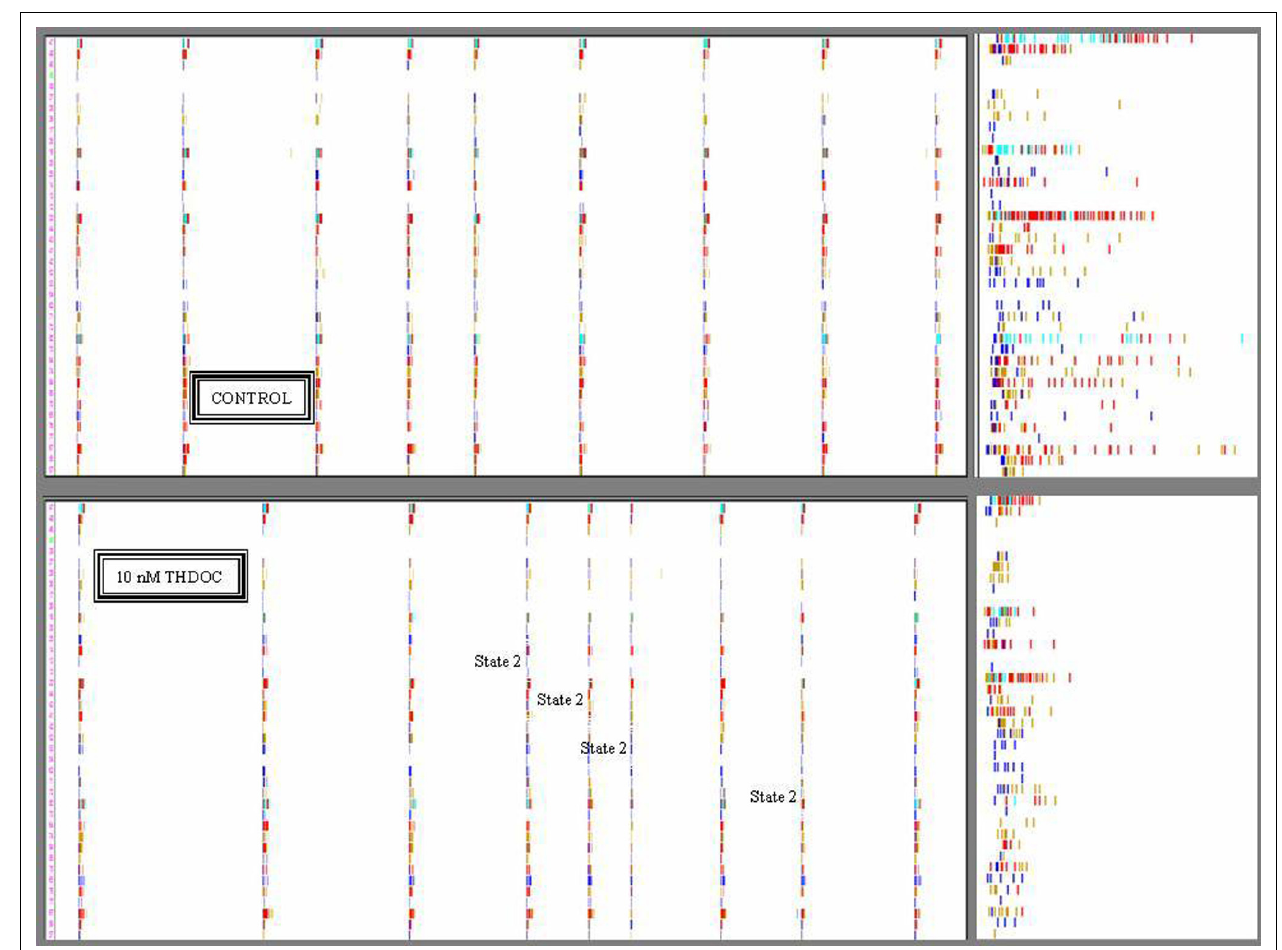
time-segment after application of 10 nMTHDOC. Notice that the legends indicate the bursts assigned to state 2 (short duration ∼ 0.5 s; 4th, 5th, 6th, and 8th) by the software-based analysis. In the right inset (time window 1 s), it is particularly clear that the duration of the sixth burst was much shorter than those not assigned to state 2. Notice also in the insets that some neurons had always either a short or a long series of spikes corresponding to excitatory or inhibitory cells, respectively. Data correspond to the experiment analyzed in Figure 4 lower at 10 nMTHDOC. Image windows obtained from the OffLine Sorter software (see Materials and